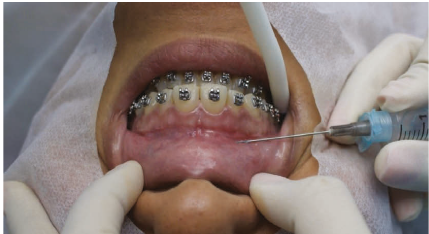
Figure 6: Insertion of polyester thread 3-0 near the subnasal region.